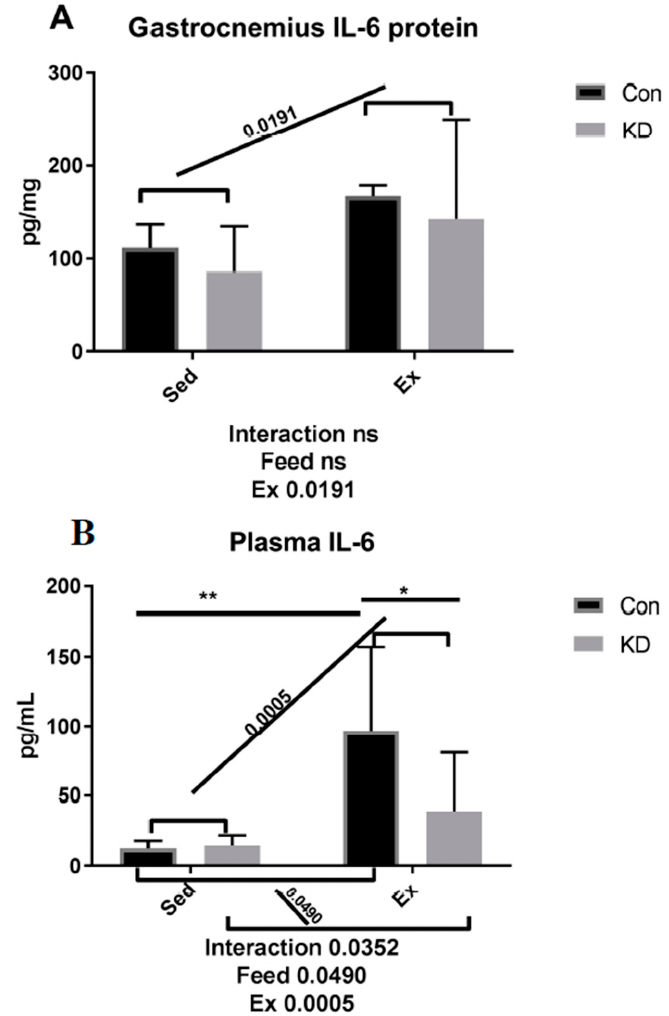
Figure 2. Interleukin-6 (IL-6) concentration in gastrocnemius ( A ) and plasma ( B ) immediately after exhaustion. ns: no significance observed. * p < 0.05 and ** p < 0.01. Significance between groups are marked using slashes.